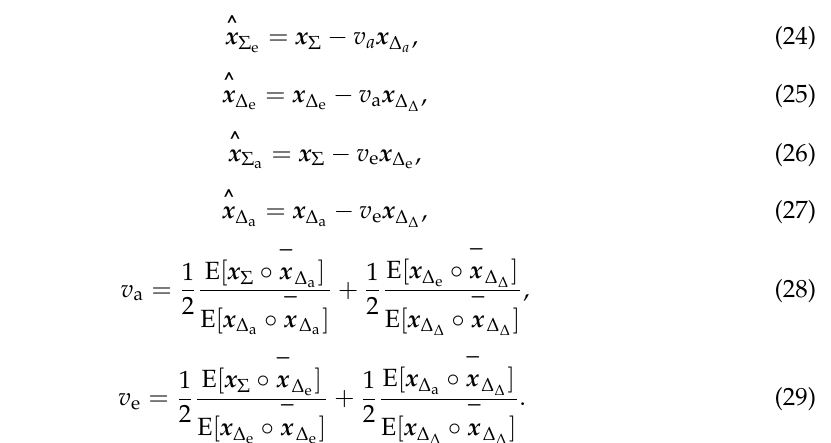
Hadamard product between vectors, and “ ( · ) ” represents conjugate